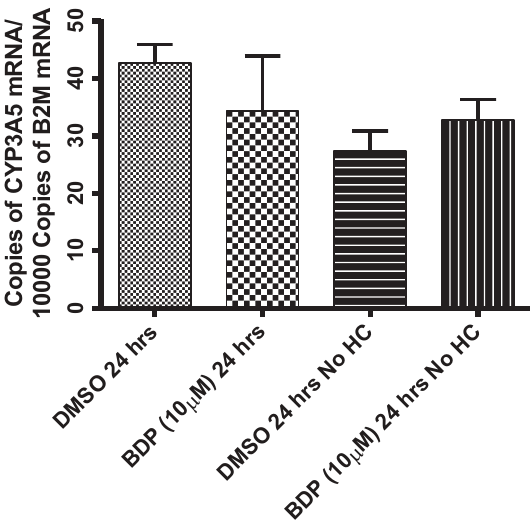
Figure 6. Beclomethasone dipropionate (BDP) treatment in SAEC cells results in no change in CYP3A5 mRNA. SAEC cells treated with BDP (10 µM; 24 h) or DMSO matching controls with and without hydrocortisone (HC). There was no significant difference between treatments or matching controls using one-way ANOVA with